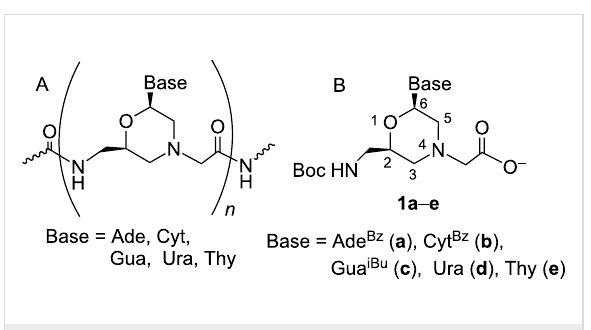
Figure 1: Morpholinoglycine oligomers (A) and protected monomers 1a – e (B) for their synthesis.